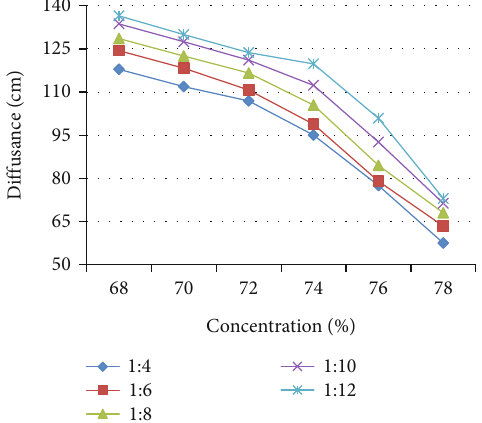
Figure 4: Relationship curve between expansion degree and concentration of total tailings mixed slurry.